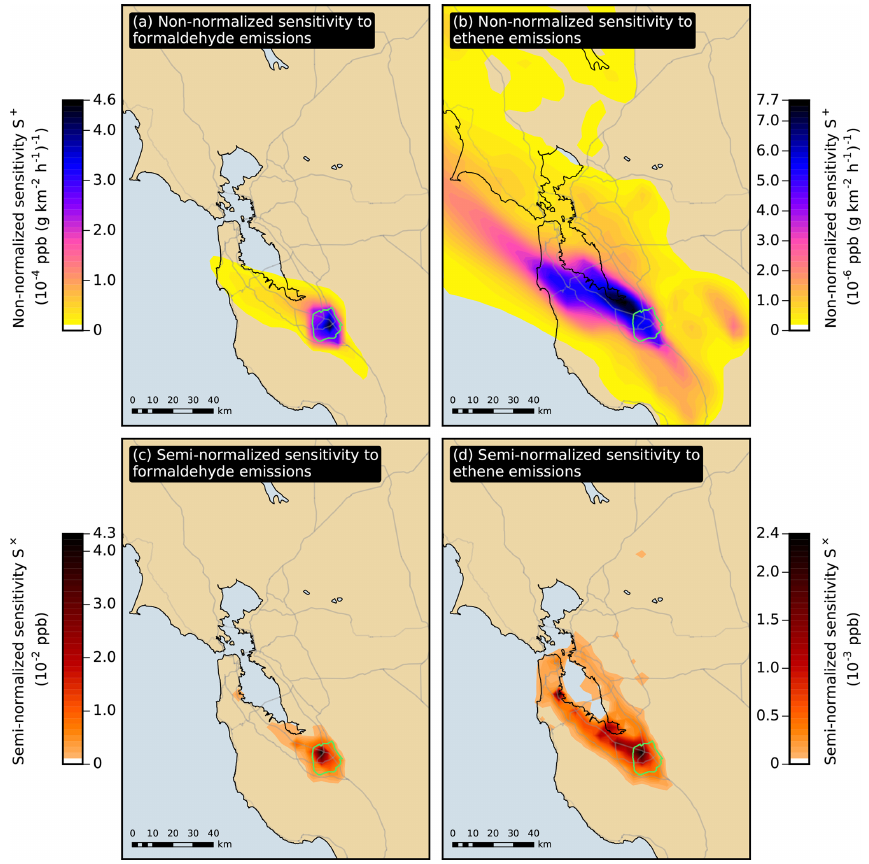
Figure 6. Non-normalized and semi-normalized sensitivity of the San Jose formaldehyde response in July to emissions of formaldehyde and ethene. At each location, the sensitivity is summed over the duration of the simulation period. The San Jose receptor area is outlined in green.